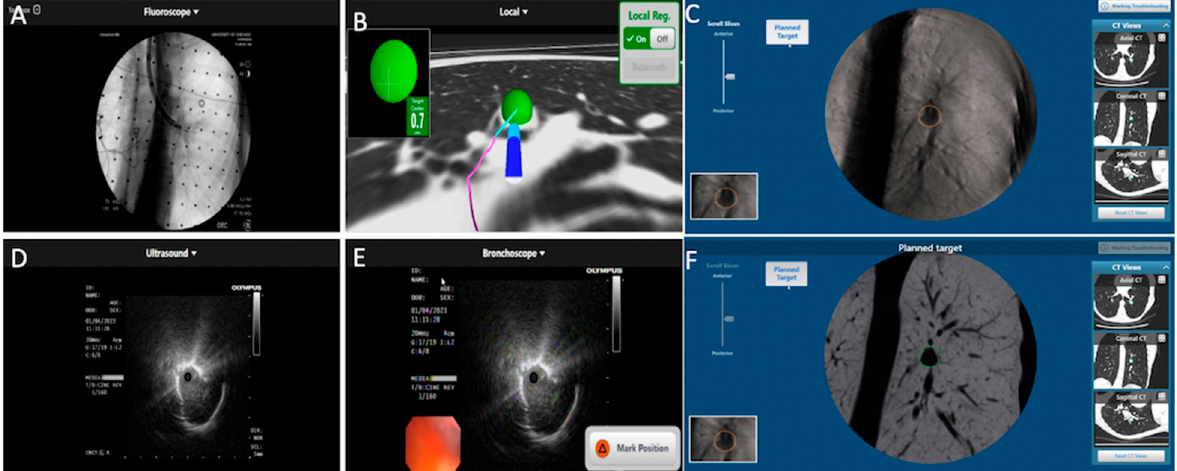
Figure 3. Illumisite ® (Medtronic) fluoroscopic navigation during bronchoscopy. ( A ) Fluoroscopy image to guide sampling, ( B ) bronchoscope in alignment with the lesion after tomosynthesis and updated lesion location, ( C , F ) planned target location visualized after tomosynthesis spin, and ( D , E ) radial EBUS imaging.